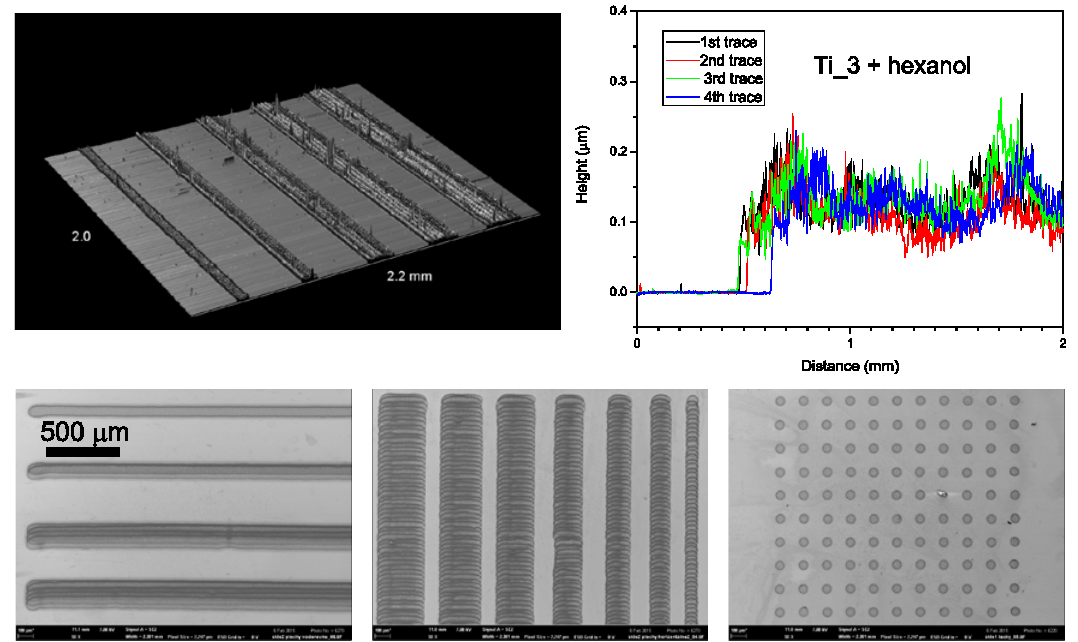
Figure 10. Profilometric mapping ( top ) and SEM images ( bottom ) of line resolution test printed with optimized Ti_3